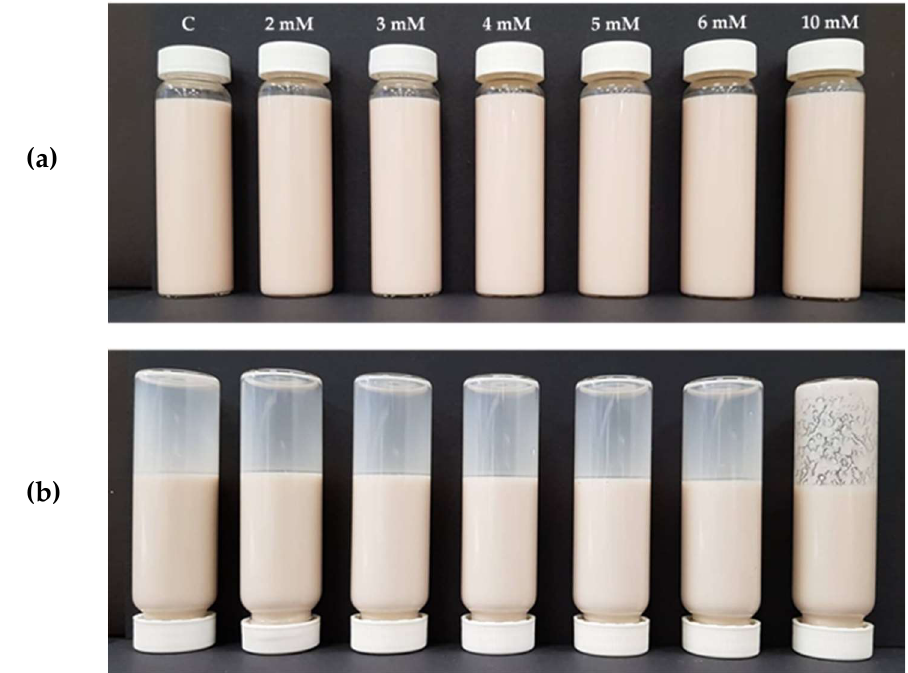
Figure 3. Photographs of lentil protein-stabilised emulsions containing. 0 (C), 2, 3, 4, 5, 6, 10 mM calcium chloride before (a) and after (b) heat treatment at 95 °C for 30 s.